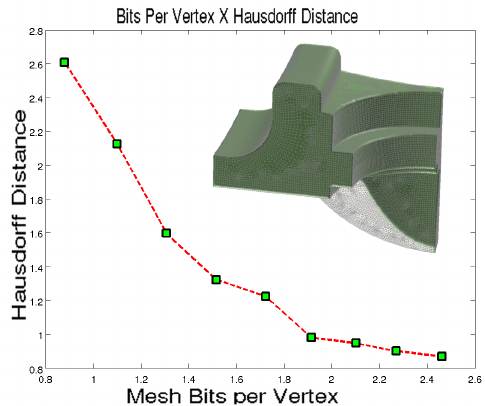
Figure 13: Hausdorff distance depending on the compression rate (BPV) to the Fandisk model